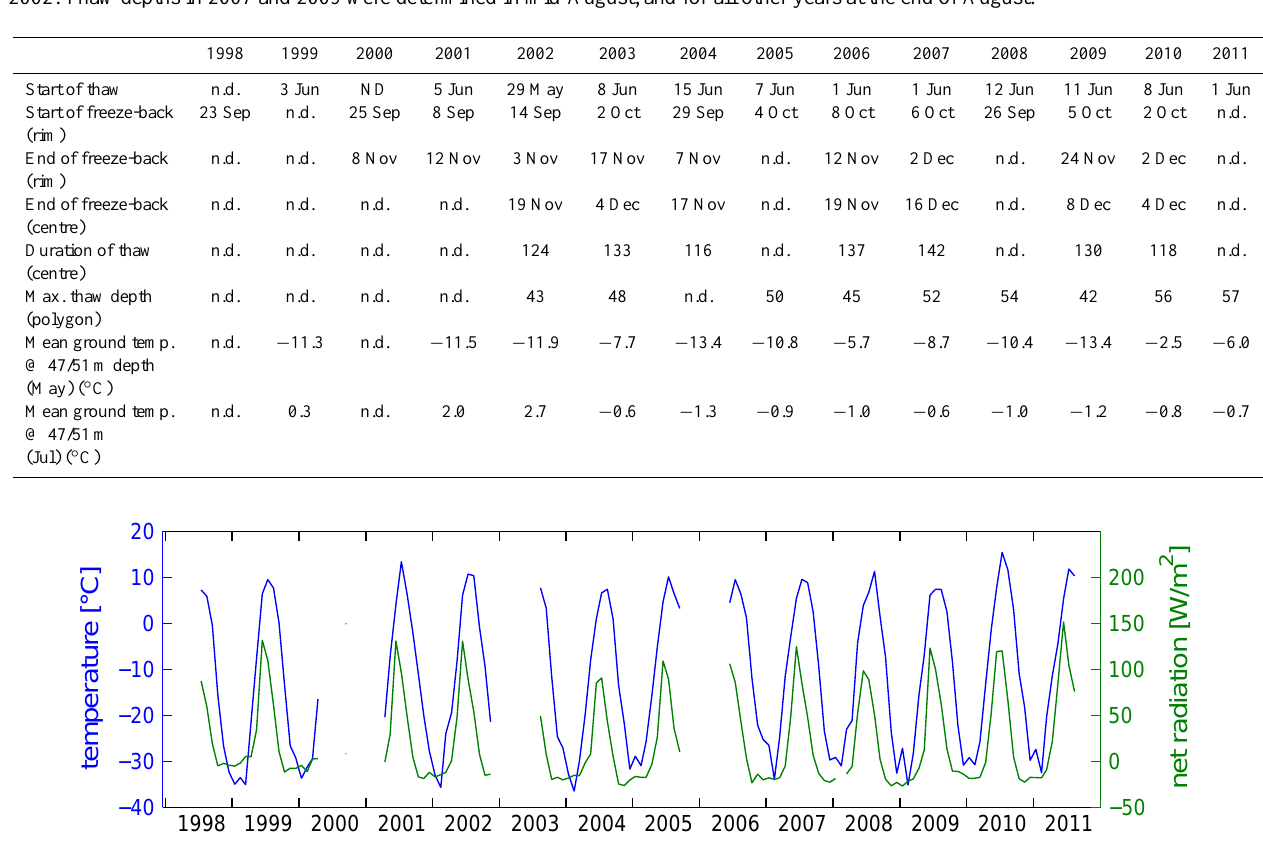
Fig. 8. Mean monthly air temperature and net radiation record for Samoylov Island, 1998-